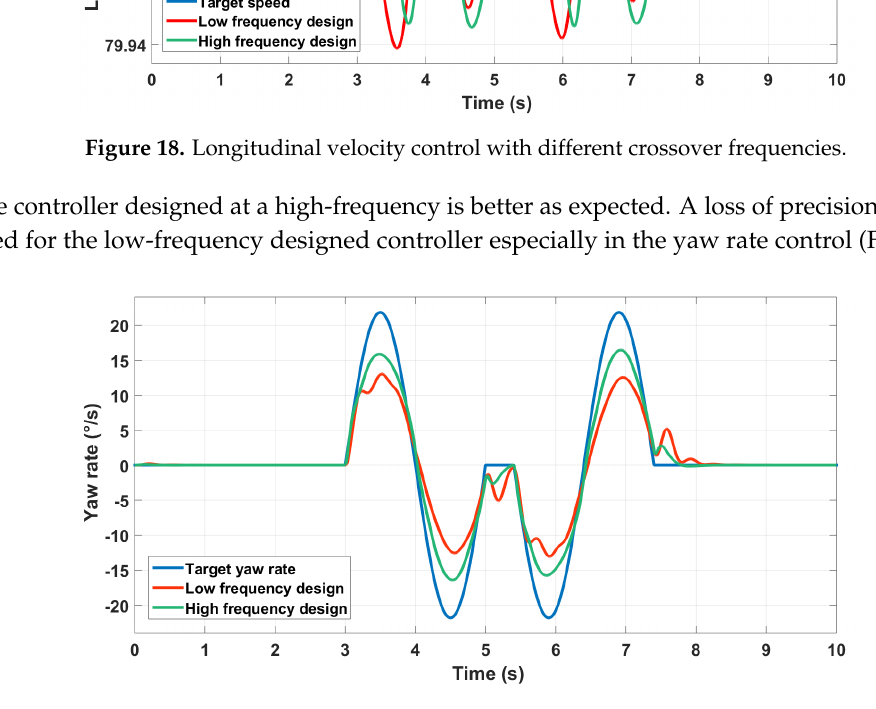
Figure 19. Yaw rate control with different crossover frequencies.